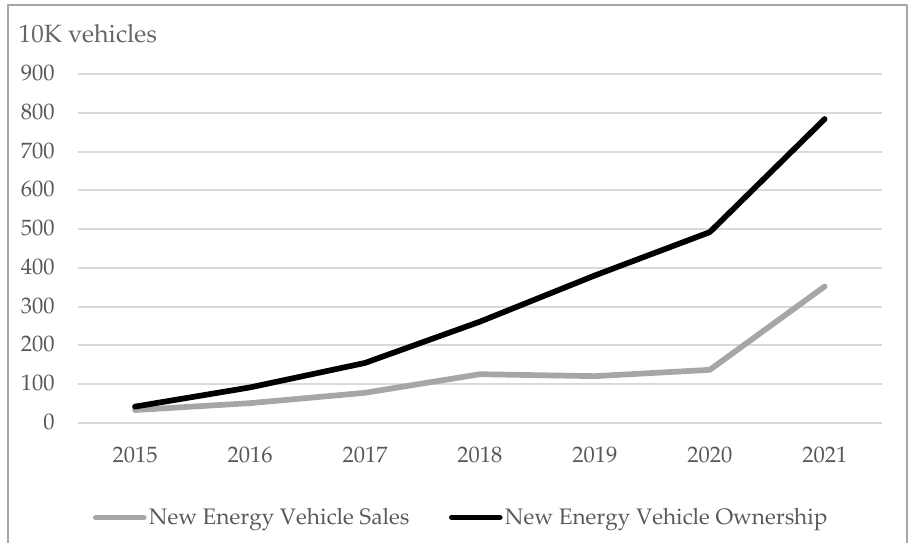
Figure 1. Trends in Sales and Ownership Indicators.